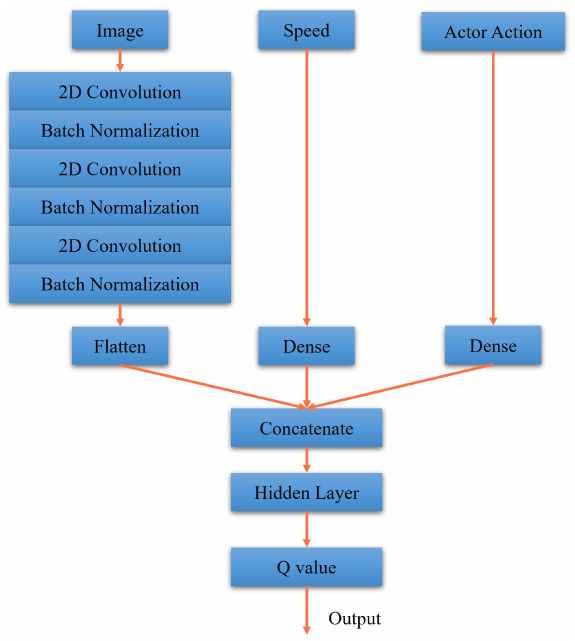
Figure 8. Our critic network for